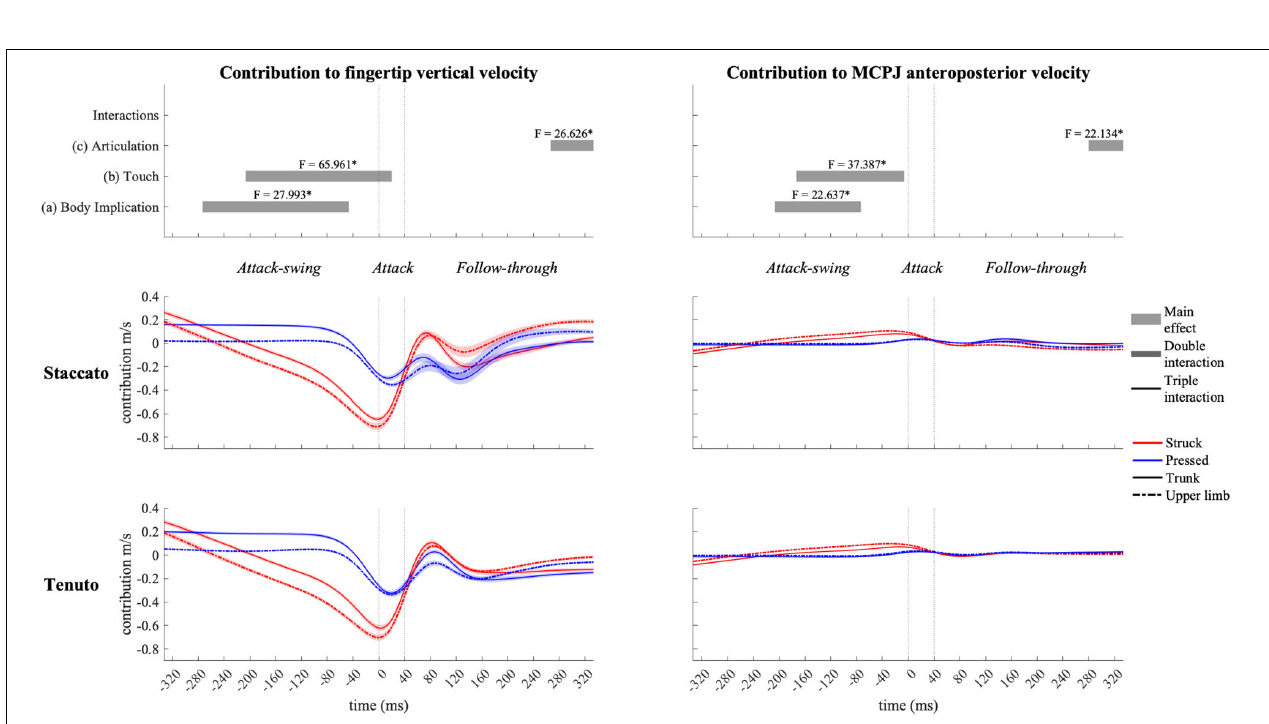
FIGURE 11 | Mean values (solid and dash-dotted lines) and 95% bootstrap confidence interval (shaded areas) of elbow-joint angular contribution to endpoint velocities during the three phases of the keystroke. Negative/positive values indicate contributions to downward/upward fingertip velocities and to backward/forward metacarpophalangeal joint (MCPJ) velocities. Top panels represent the results from the statistical parametric mapping of time-series values. * p -value ≤ 0.001.